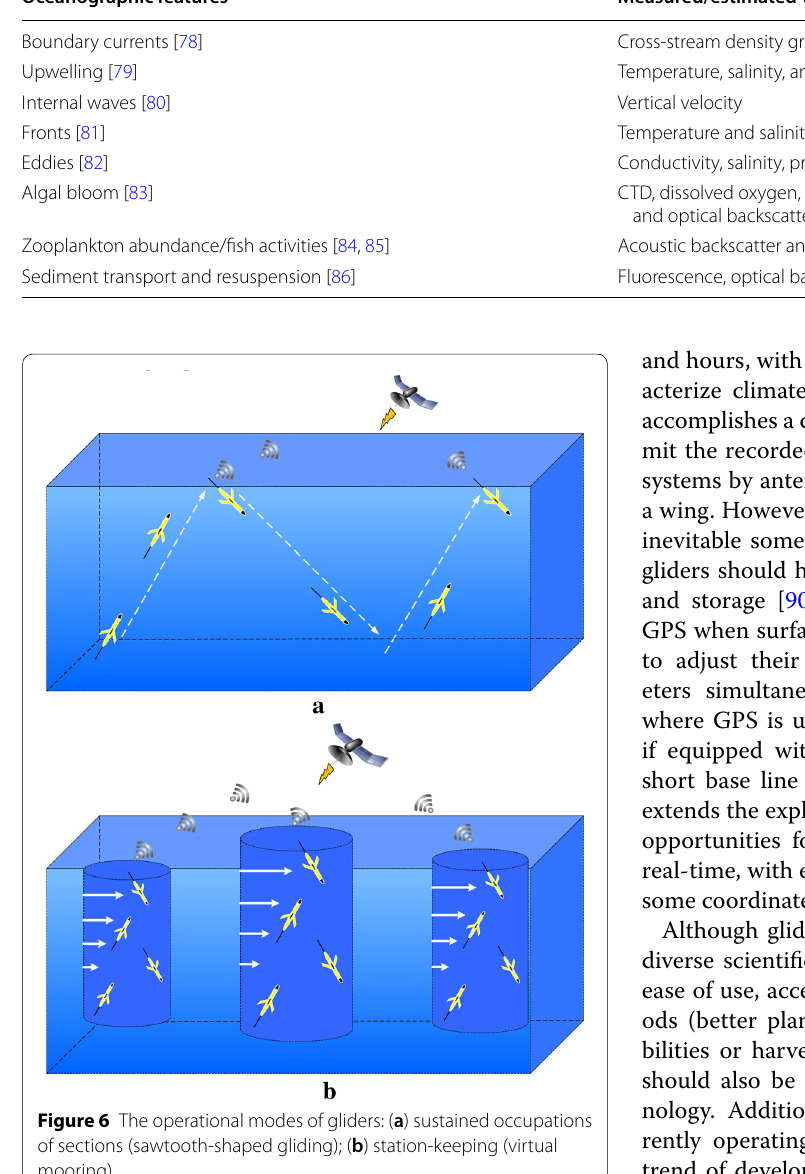
Table 2 Applications in observing oceanographic features Oceanographic features